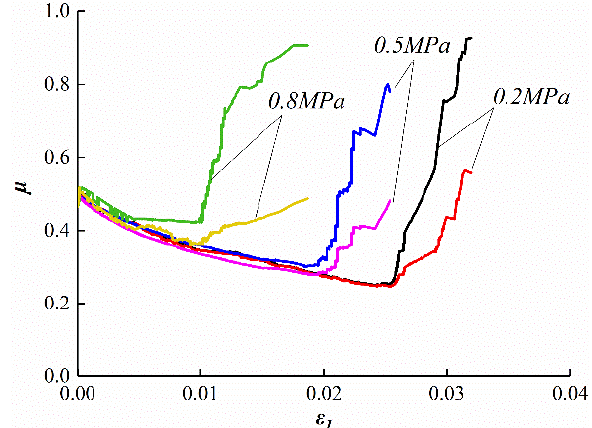
Figure 7. Poisson’s ratio curve.